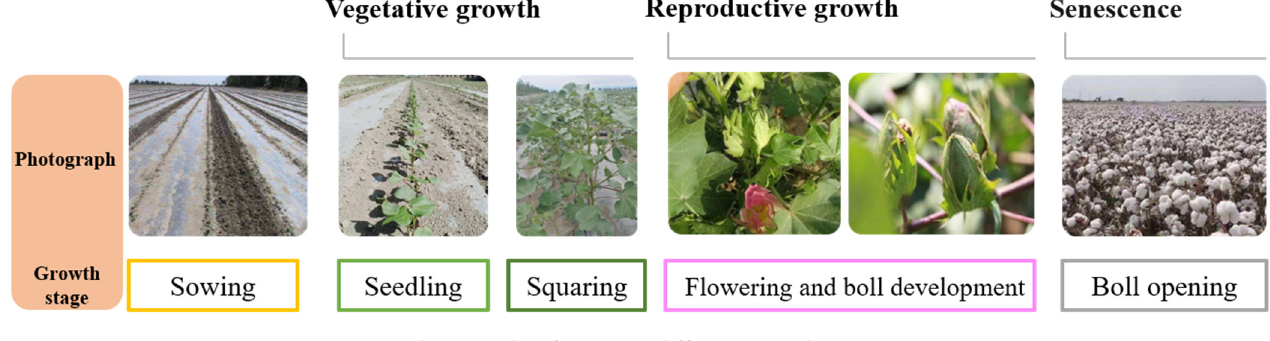
Figure 2. Photographs of cotton at different growth stages.